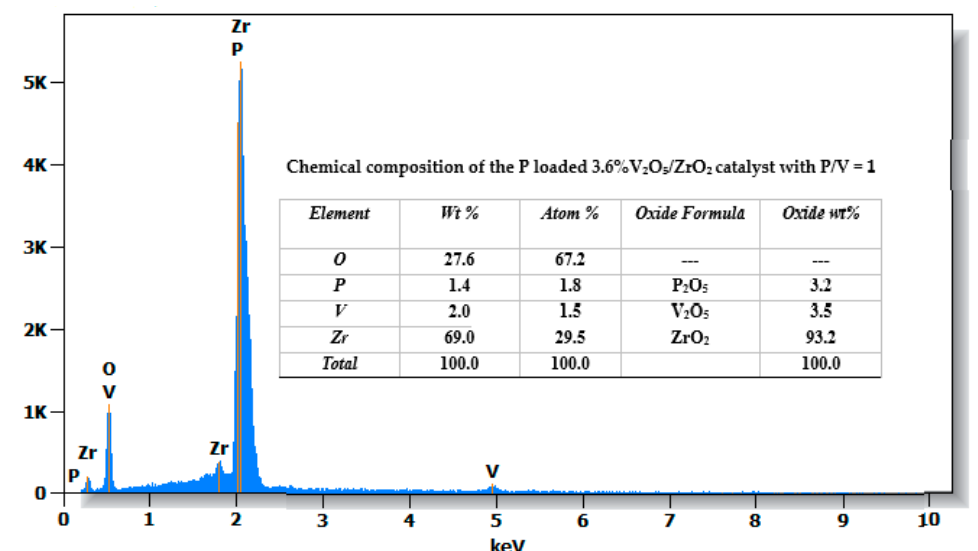
Figure 8. EDX spectrum and chemical composition of P loaded 3.6wt%V 2 O 5 /ZrO 2 catalyst with P/V = 1.